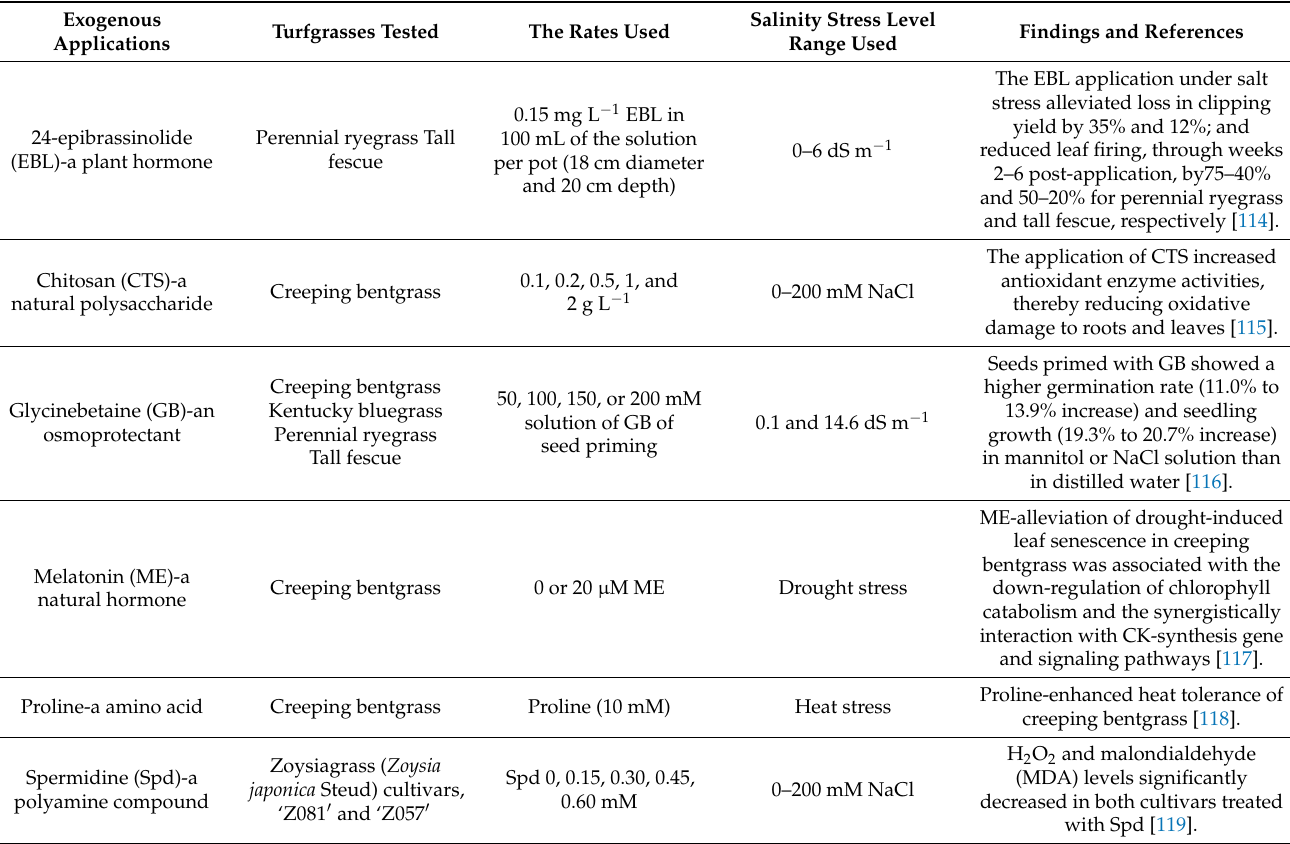
Table 3. Some trials on mitigation of salinity, heat, and drought stresses by exogenous applications of plant metabolites among turfgrass